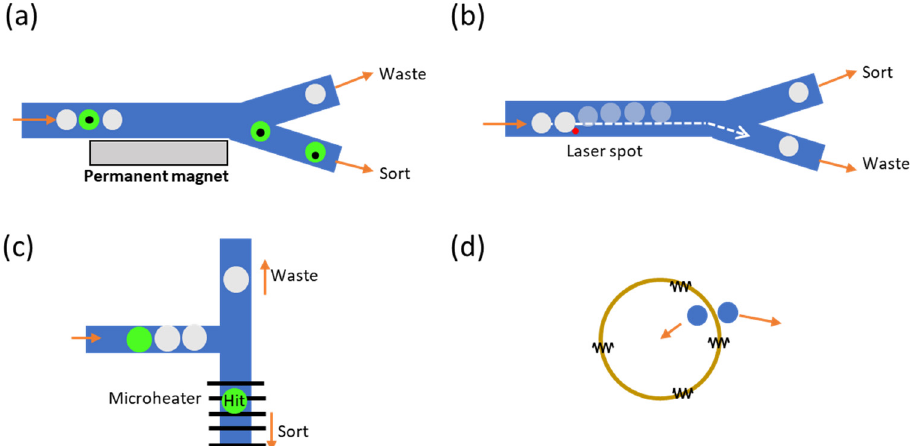
Figure 7. Variety of different versions of other droplet sorters. ( a ) A magnetic droplet sorter that can utilize either permanent magnet or electromagnet to achieve selective droplets with magnetic beads labeled droplets. ( b ) A laser beam focused spot can generate a localized thermocapillary effect, so that force can be generated at the oil–aqueous interface, to deter the trajectory of droplets. ( c ) Resistive heating at the downstream channel would decrease the fluidic resistance and achieve droplet sorting function. ( d ) An optical tweezer that can manipulate the droplets near the laser ring.